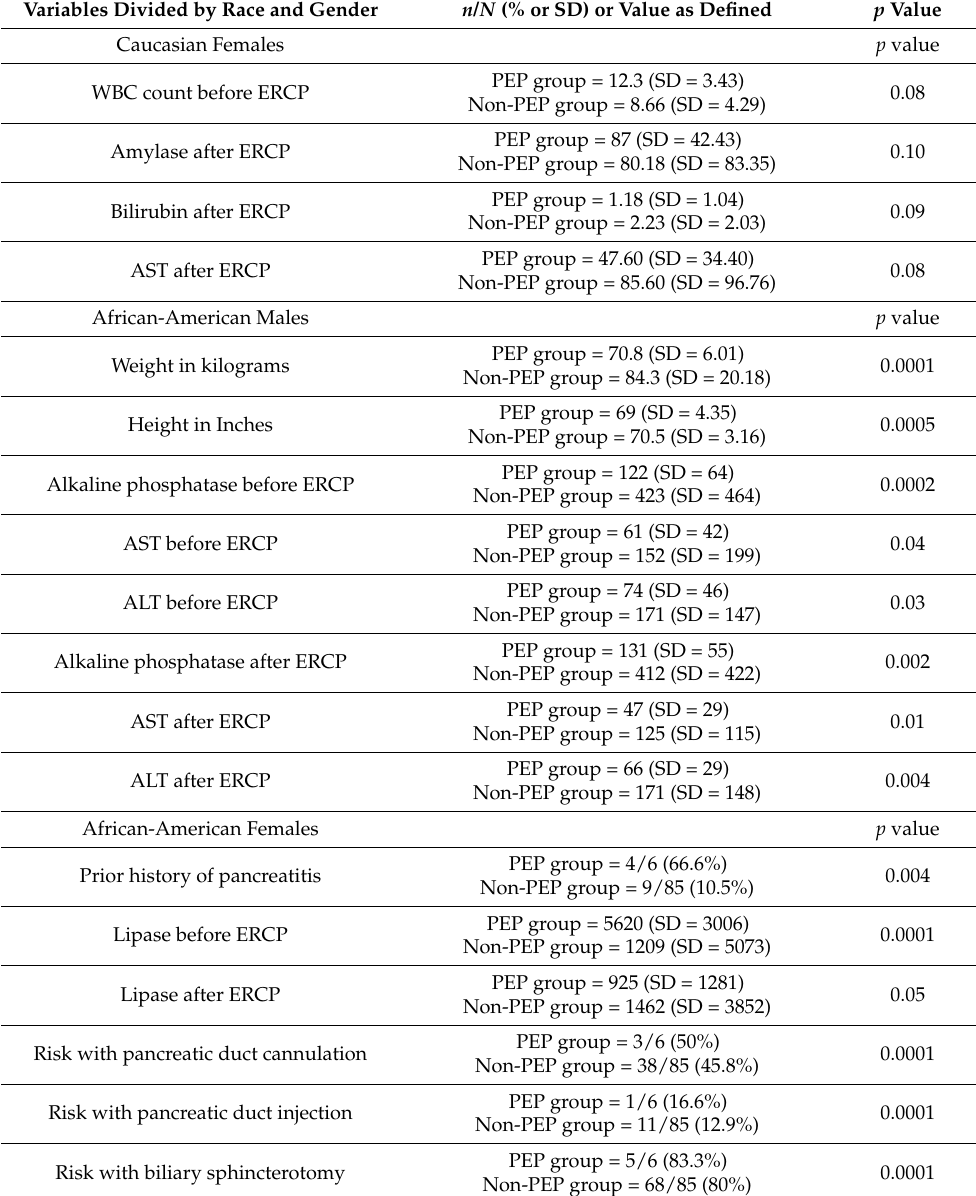
Table 3. Cont. Variables Divided by Race and